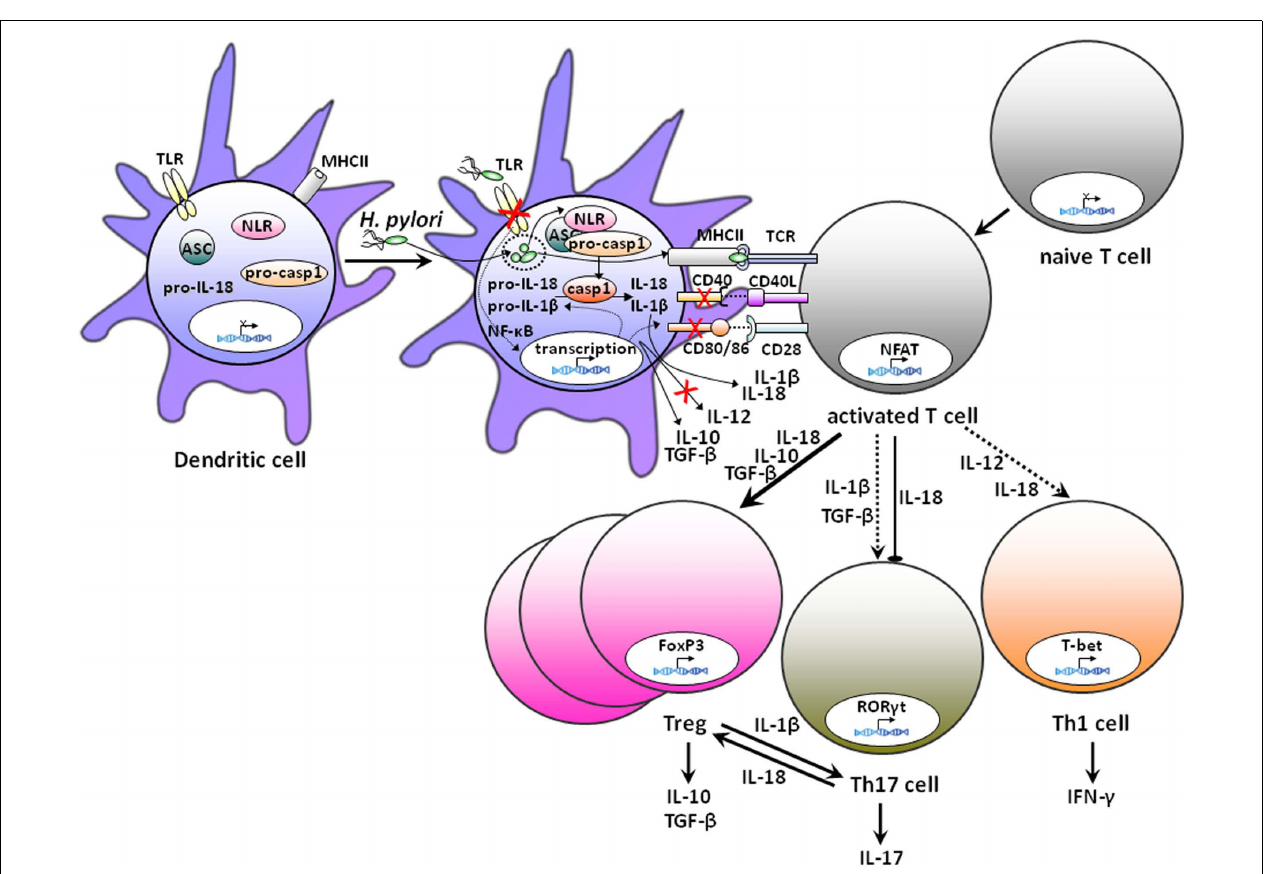
differentiation. H. pylori -experienced DCs actively induce the conversion of naiveT-cells to FoxP3 + Tregs in a process that requires IL-18,TGF- β , and possibly IL-10. In contrast, H. pylori -experienced DCs are poor inducers of Th17 andTh1 differentiation.The documented lack of H. pylori TLR ligands in conjunction with efficient inflammasome activation by the bacteria suggests that the relative availability of pro-IL-1 β (low level expression due to lack of transcriptional activation) and pro-IL-18 (high levels due to constitutive expression) for caspase-1 processing may dictate the outcome of the DC/T-cell